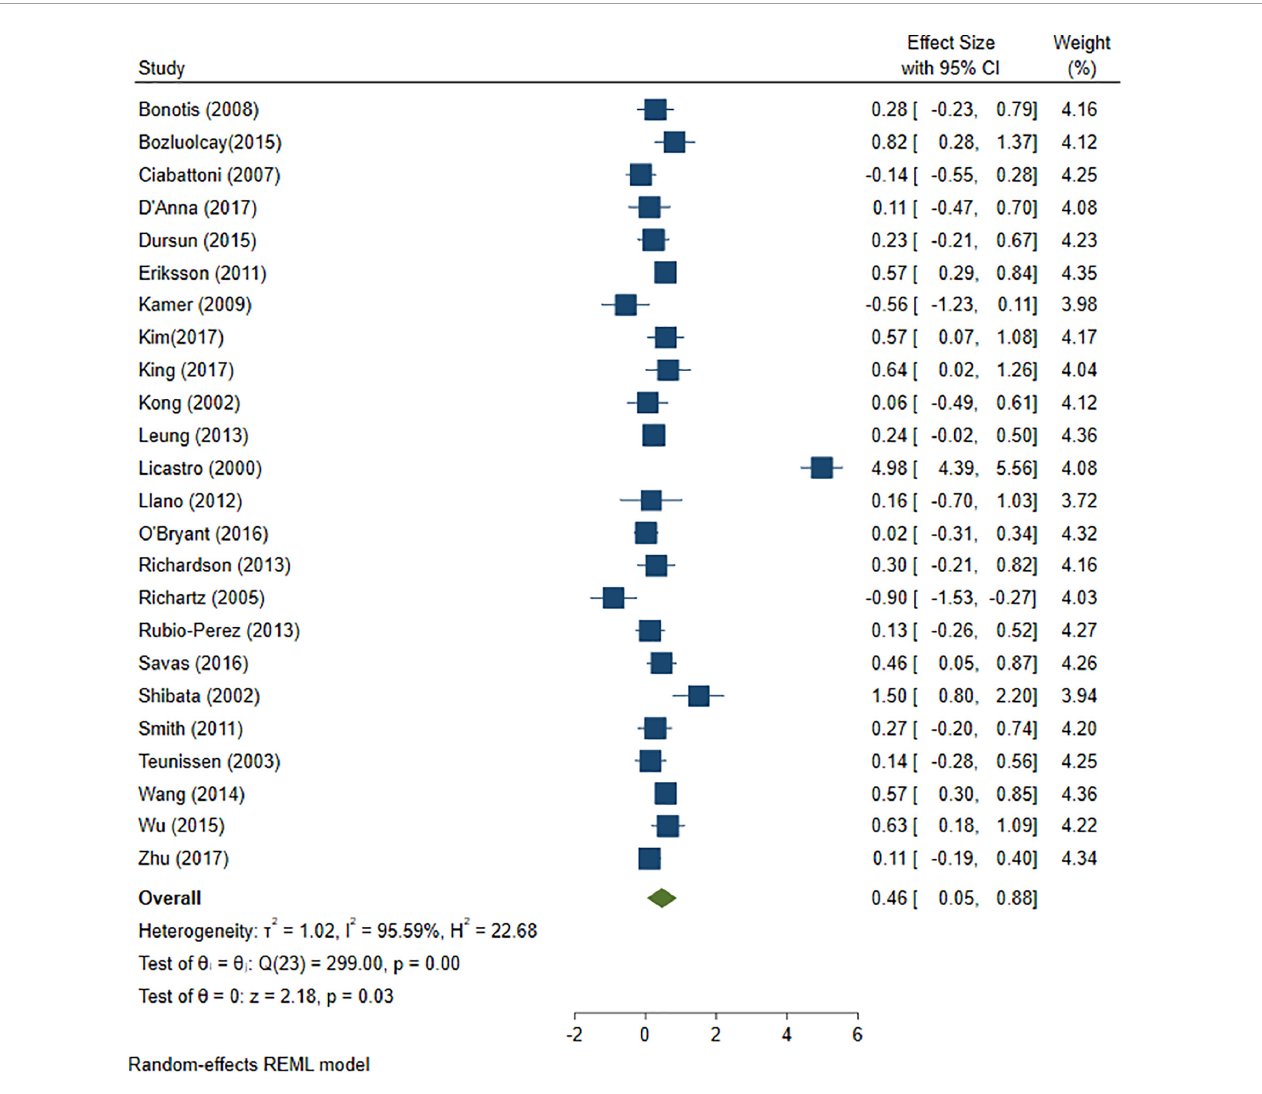
ACT [OR = 1.6, 95% CI (0.9, 2.29)] Albumin [OR = 1.12, 95% CI (0.61, 1.63)] nor TNF [OR = 1.23, 95% CI (0.91, 1.55)] had a statistically significant effect on cognitive impairment. The pooled analysis was homogeneous (I2 = 0%, p = 0.5) ( Figure 12A ). Funnel plots of the inverse of the standard error vs. the ES demonstrated asymmetry ( Figure 12B ). However, Egger’s test ( P = 0.08) and Begg’s test ( P = 0.13) indicated no small-study